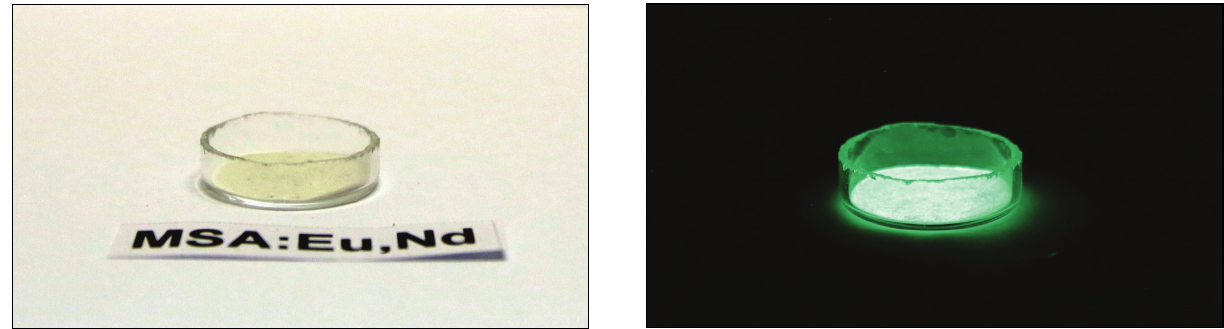
Figure 4. Photographs of the MSA:0.5Eu 2+ ,0.25Nd 3+ sample annealed at 1300 °C in light (left) and the green luminescence in the dark (right) after the UV